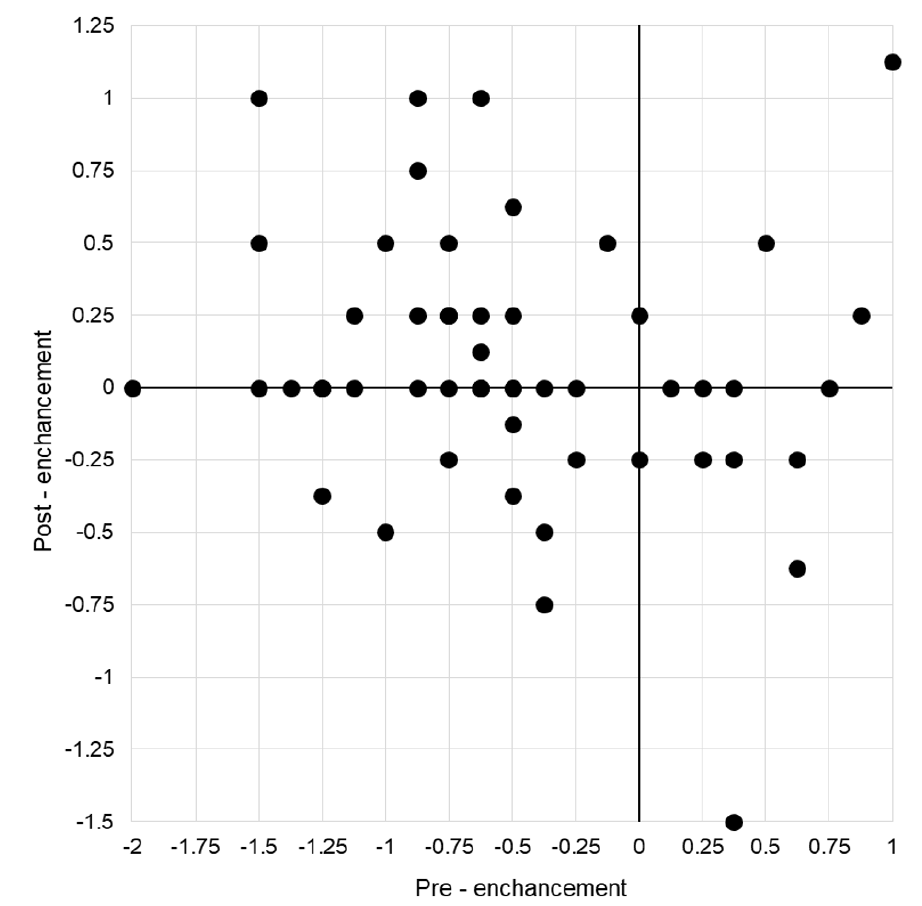
Fig. 2. Interdependence of pre-enhancement and post-enhancement spherical equivalent in diopters.